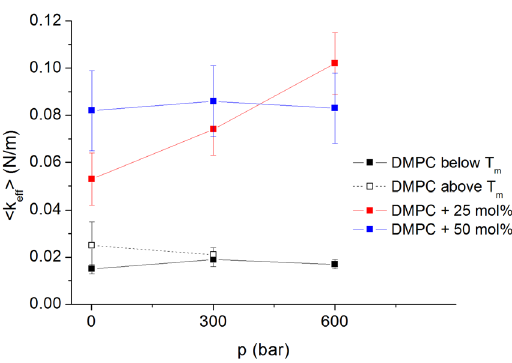
Figure 4. Effective force constants as function of pressure for DMPC and two different sterol concentrations. The values for DMPC are taken from ref. 31